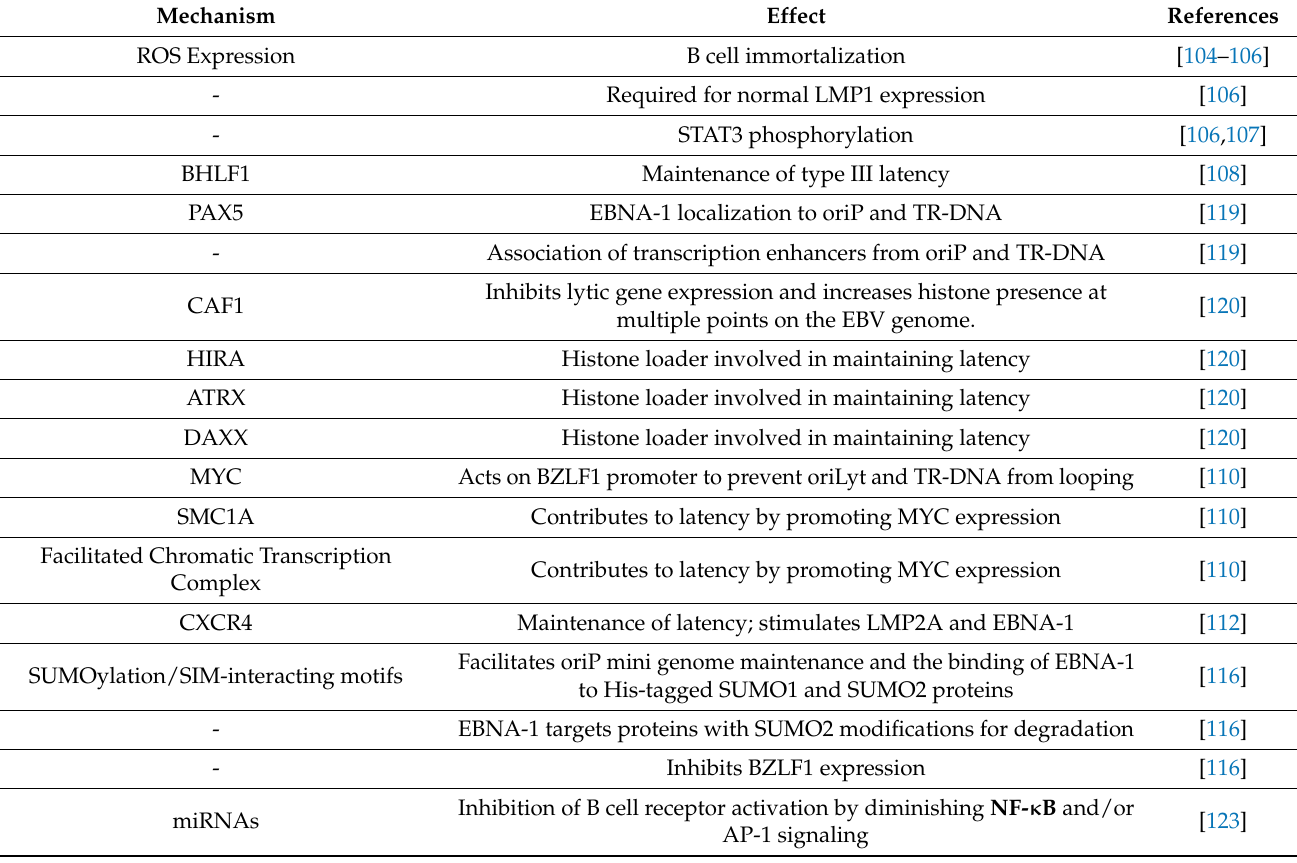
Table 1. Mechanisms Involved in EBV